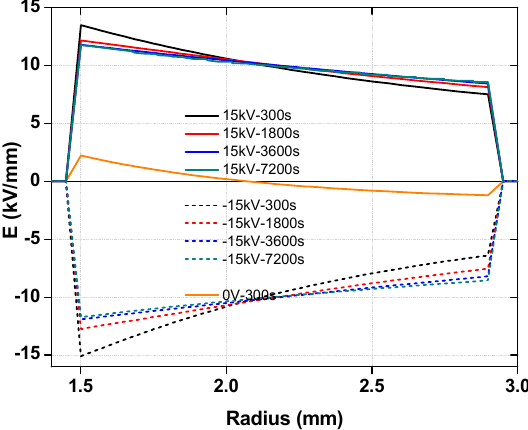
Figure 10. Modeled field distribution profiles in a cable sample under voltage inversion applied and at isotherm condition at T = 65 °C.